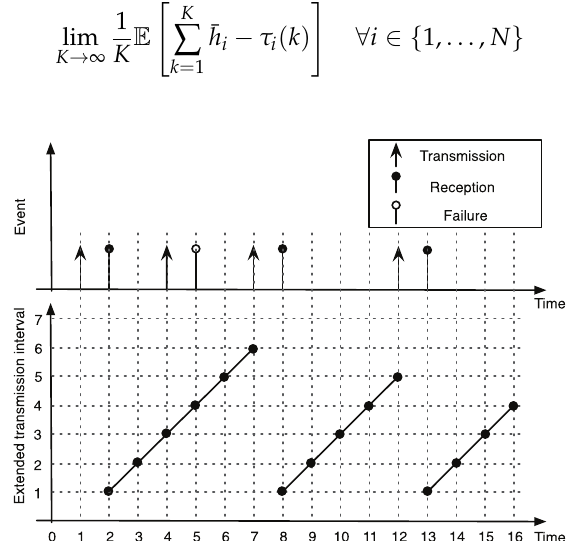
Figure 5. Illustration of a typical evolution of